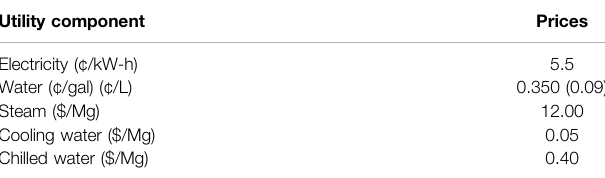
TABLE 1 | Detailed investment of CHP integrated with FW fermentation plant. TABLE 2 | Utility prices (EIA